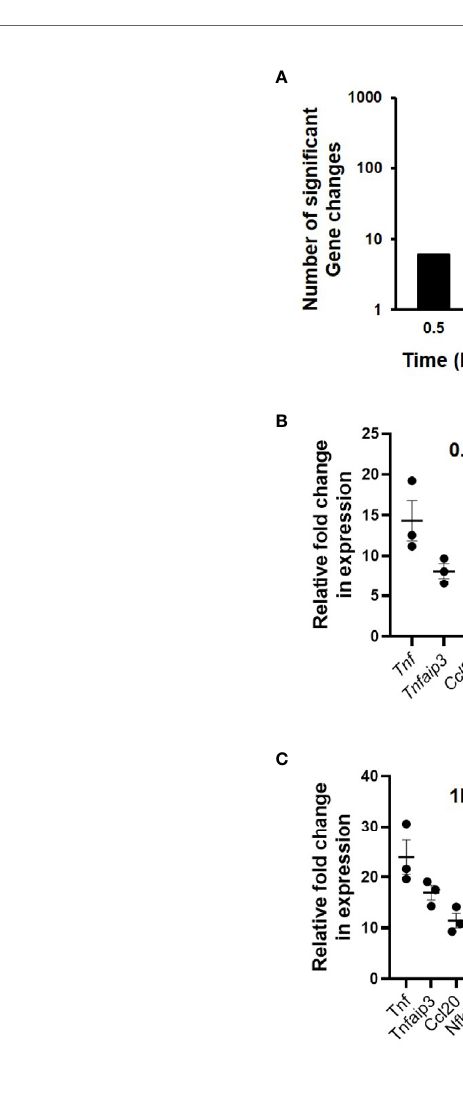
FIGURE 2 | Gene expression changes in TNF-stimulated C57BL/6J enteroids as assessed by RNA sequencing. Enteroid cultures were left unstimulated or stimulated with 40 ng/ml TNF for 0.5, 1, 2, and 24 h. Total RNA was isolated, sequencing was performed, followed by informatics analysis. (A) Total number of differentially expressed genes across all time points sampled and fold change in expression of speci fi c genes at (B) 0.5, and (C) 1 h post-TNF treatment (N = 3 mice). All genes presented were identi fi ed as being signi fi cantly upregulated; p < 0.05 (calculated based on log2 fold changes between stimulated and unstimulated controls, and corrected for multiple testing using the Benjamini and Hochberg